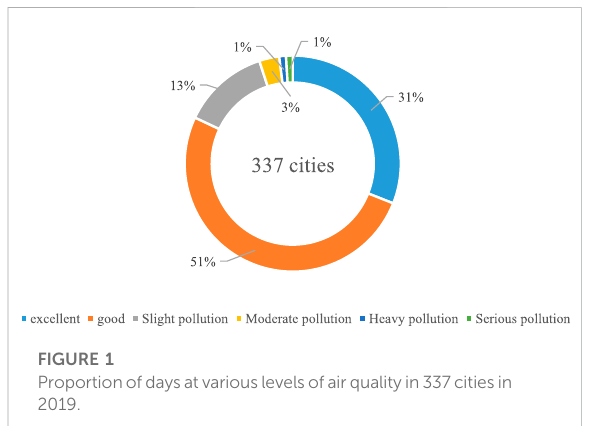
FIGURE 1 Proportionofdaysatvariouslevelsofairqualityin337citiesin